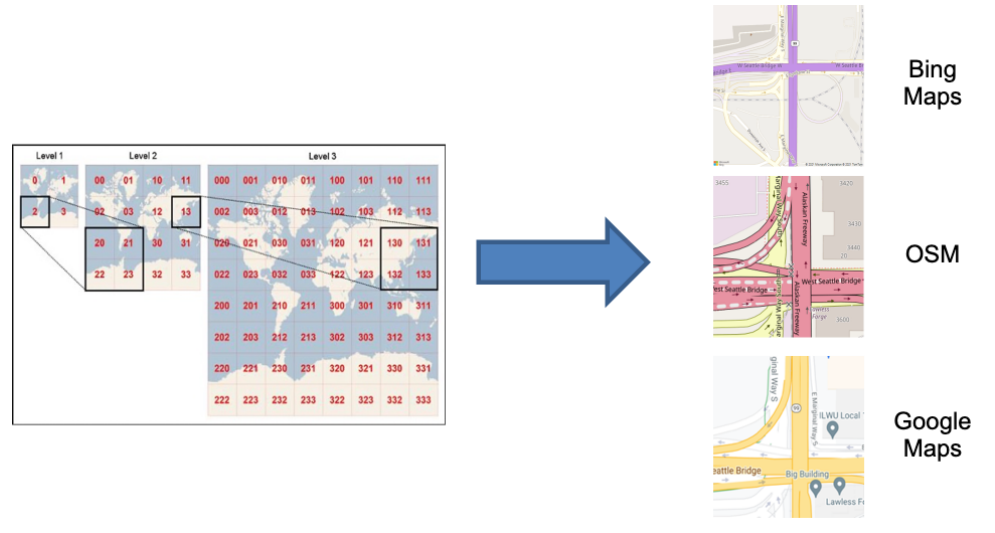
Figure 5. Bing Maps Tile System [30].